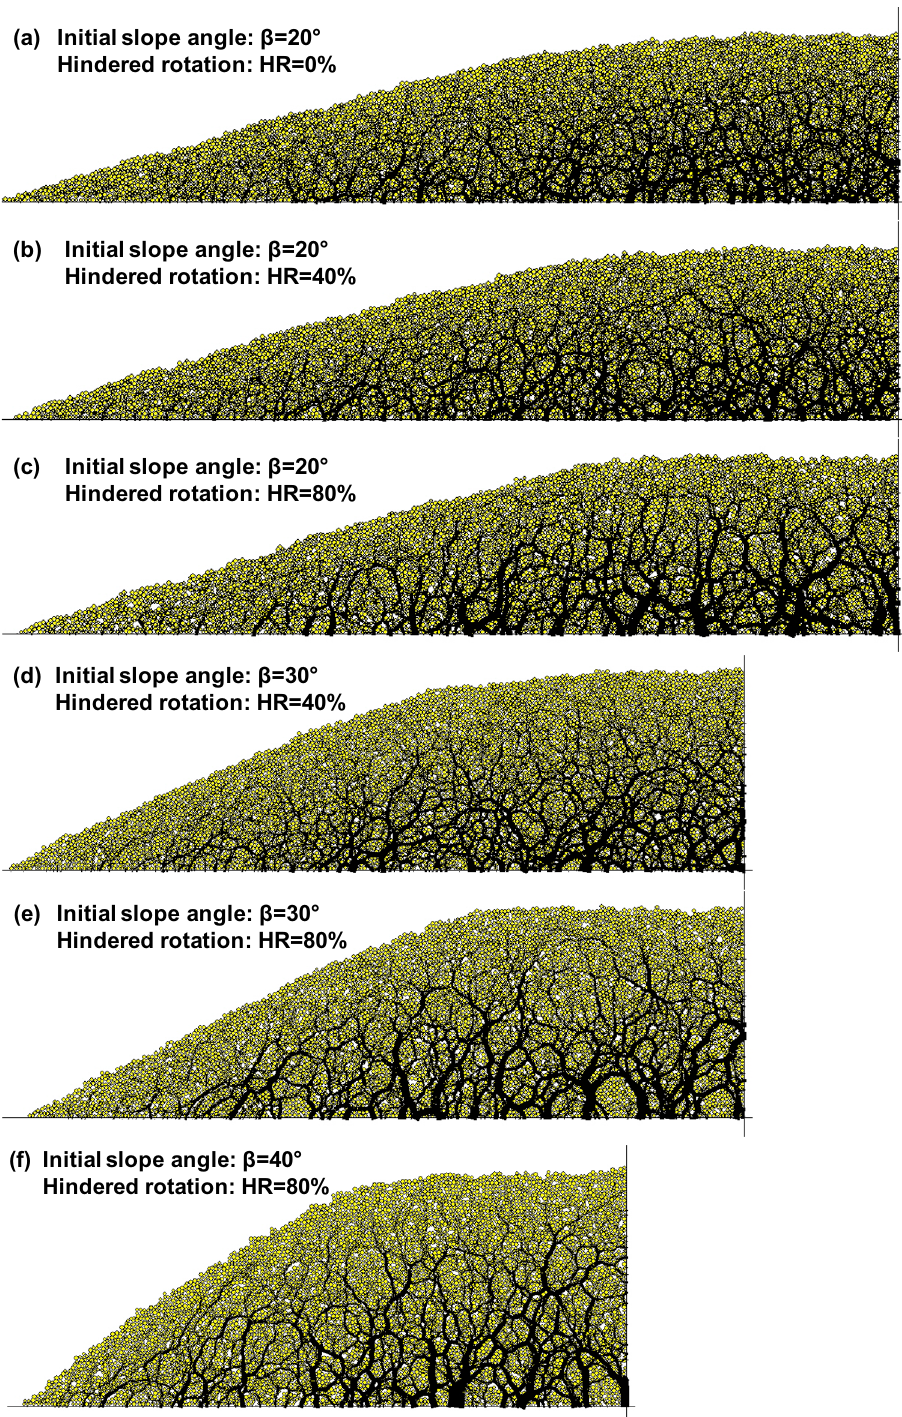
Figure 6. Contact force chains at the end of dissolution – All cases are shown at the same force scale. Note: Compare these results to those shown in Fig.